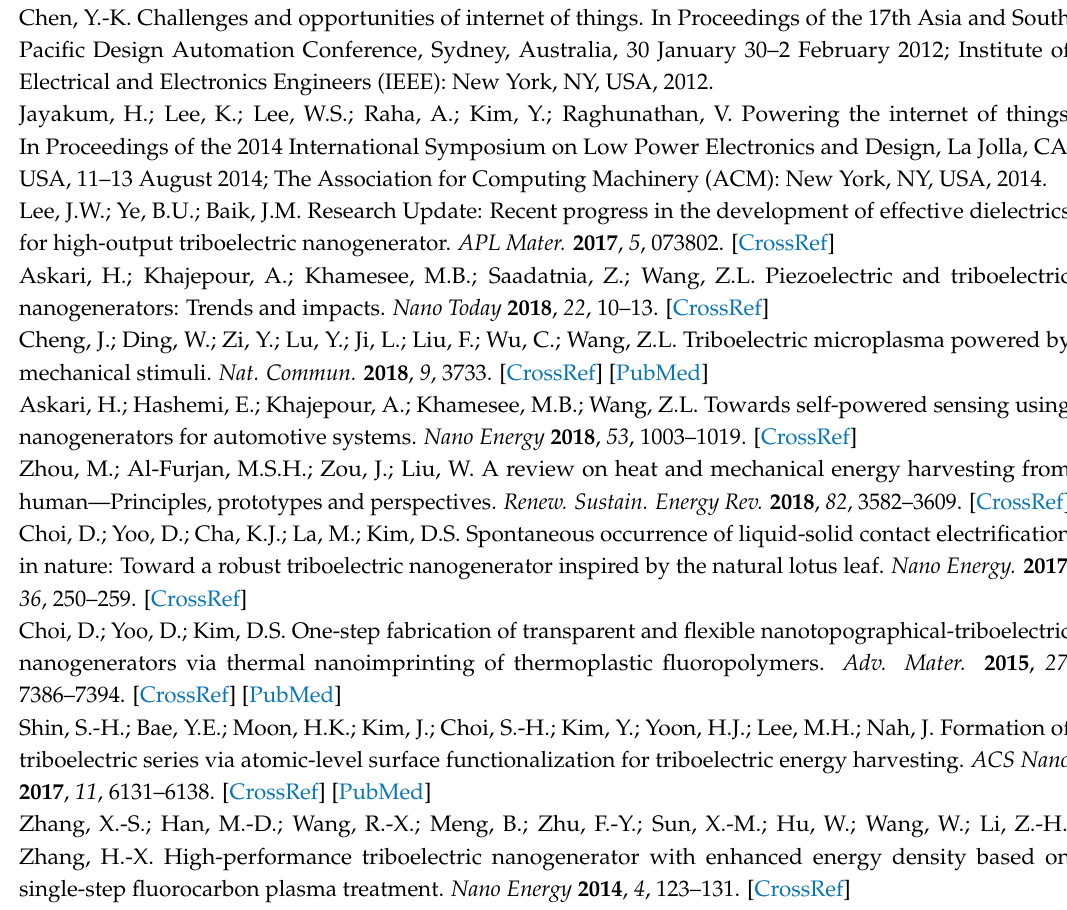
Figure S1: Focused ion beam image of TENG_ME, Figure S2: 3D profiler images of Al electrodes, Figure S3: The effect of triggering frequency on the V OC of the TENG_ME, Figure S4: Long-lasting performance of the TENG_ME, Video S1: Lightening LEDs by TENG_ME, Video S2: Operating a conventional electronic calculator by